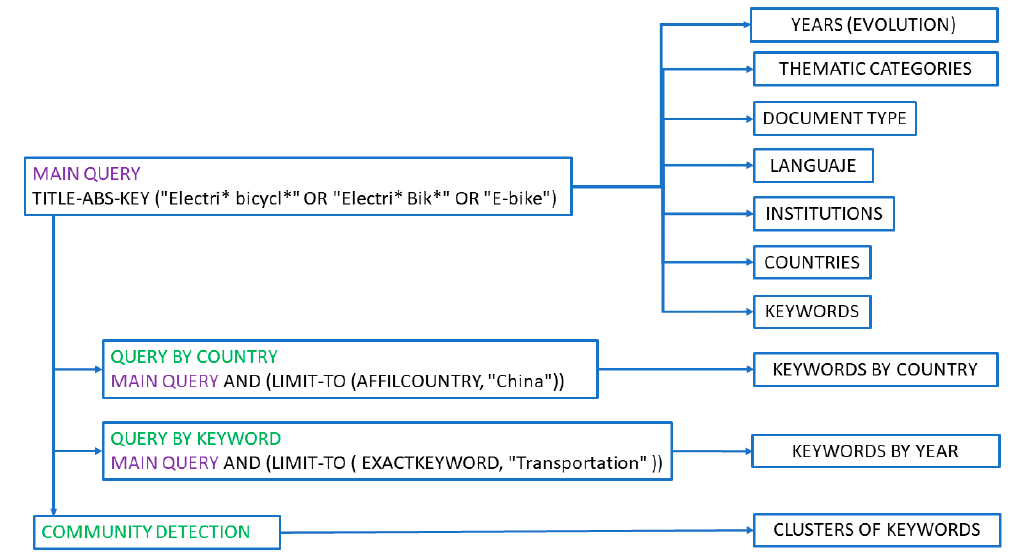
Figure 1. Methodology. Figure 1.